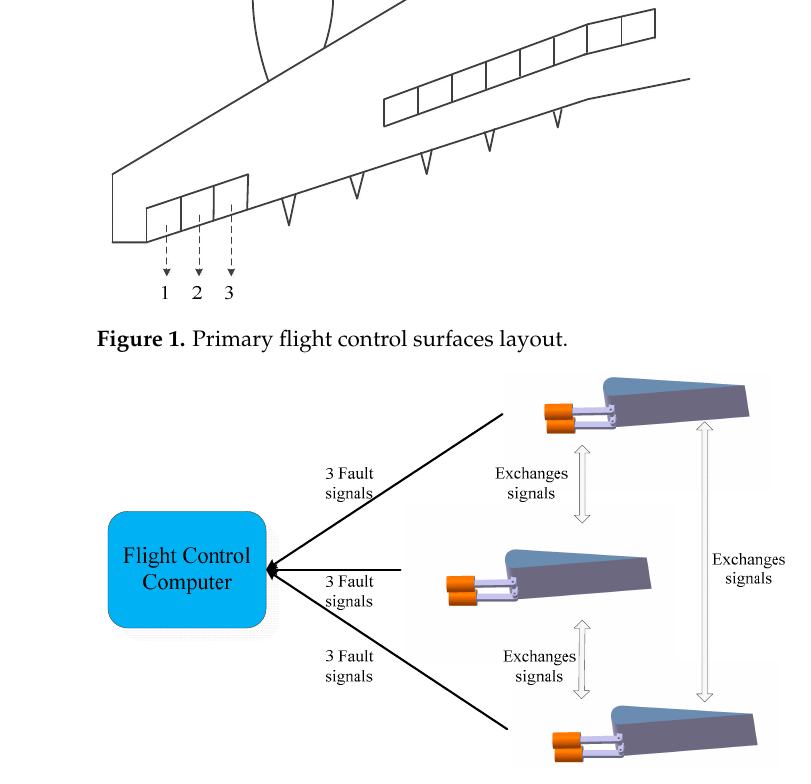
Figure 2. Topology structure of the multi-agent system.